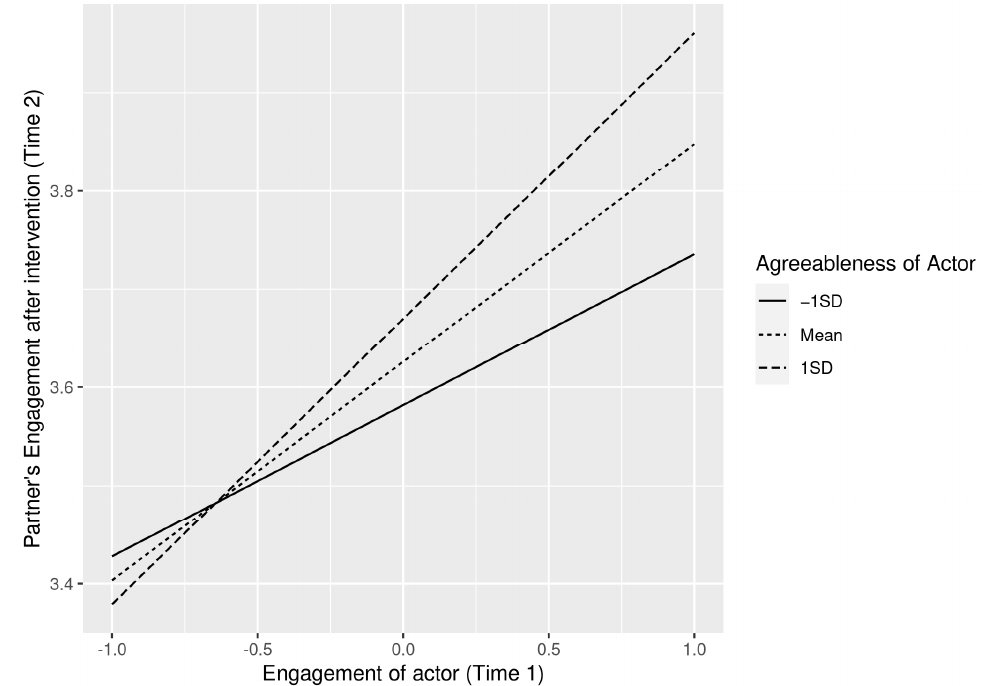
Figure 3. Interaction effect between an actors’ engagement and their agreeableness on their partners’ engagement .